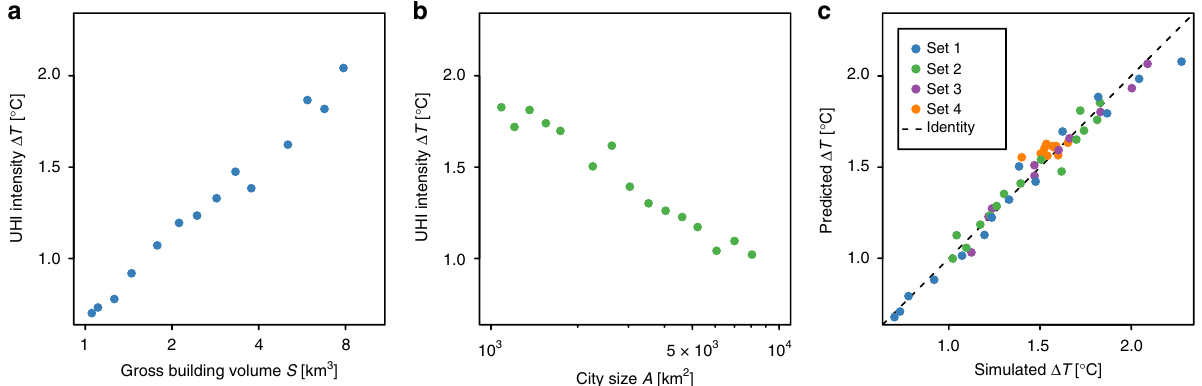
Fig. 2 UHI intensity as a function of city characteristics and fi tting performance of Eq. (1). a The UHI intensity is plotted vs. gross building volume for constant city size. b The UHI intensity is plotted vs. city size for constant gross building volume. c Predicted and simulated UHI intensities are plotted against each other. Supplementary Fig. 1 illustrates the various sets of generated clusters.